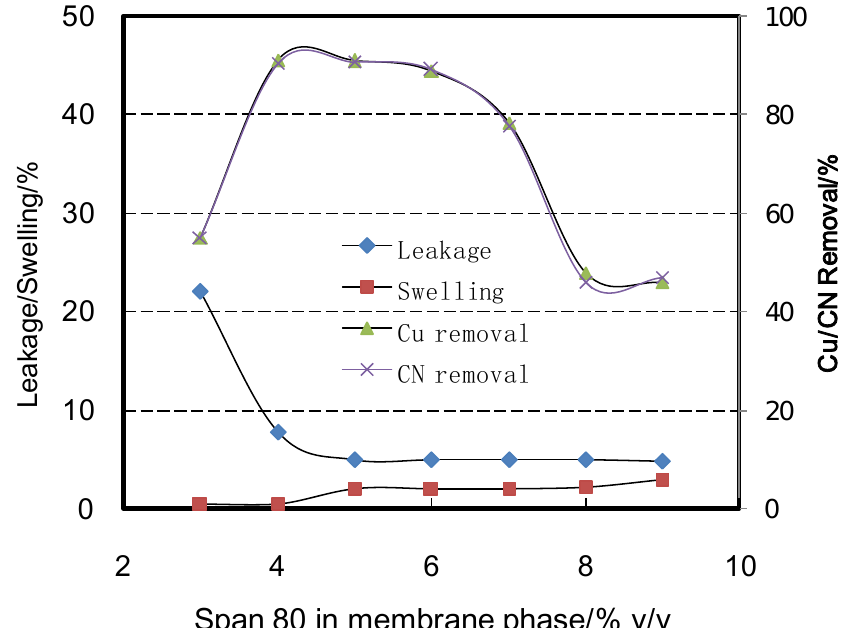
Figure 6. Effect of Span 80 concentration on ELM stability and copper and cyanide removal. (For ELMs formation, membrane phase: 2% v / v 1-dodecanol, 1% v / v liquid paraffin, balanced with kerosene; Internal phase: 0.05 mol/L KOH solution. Volume